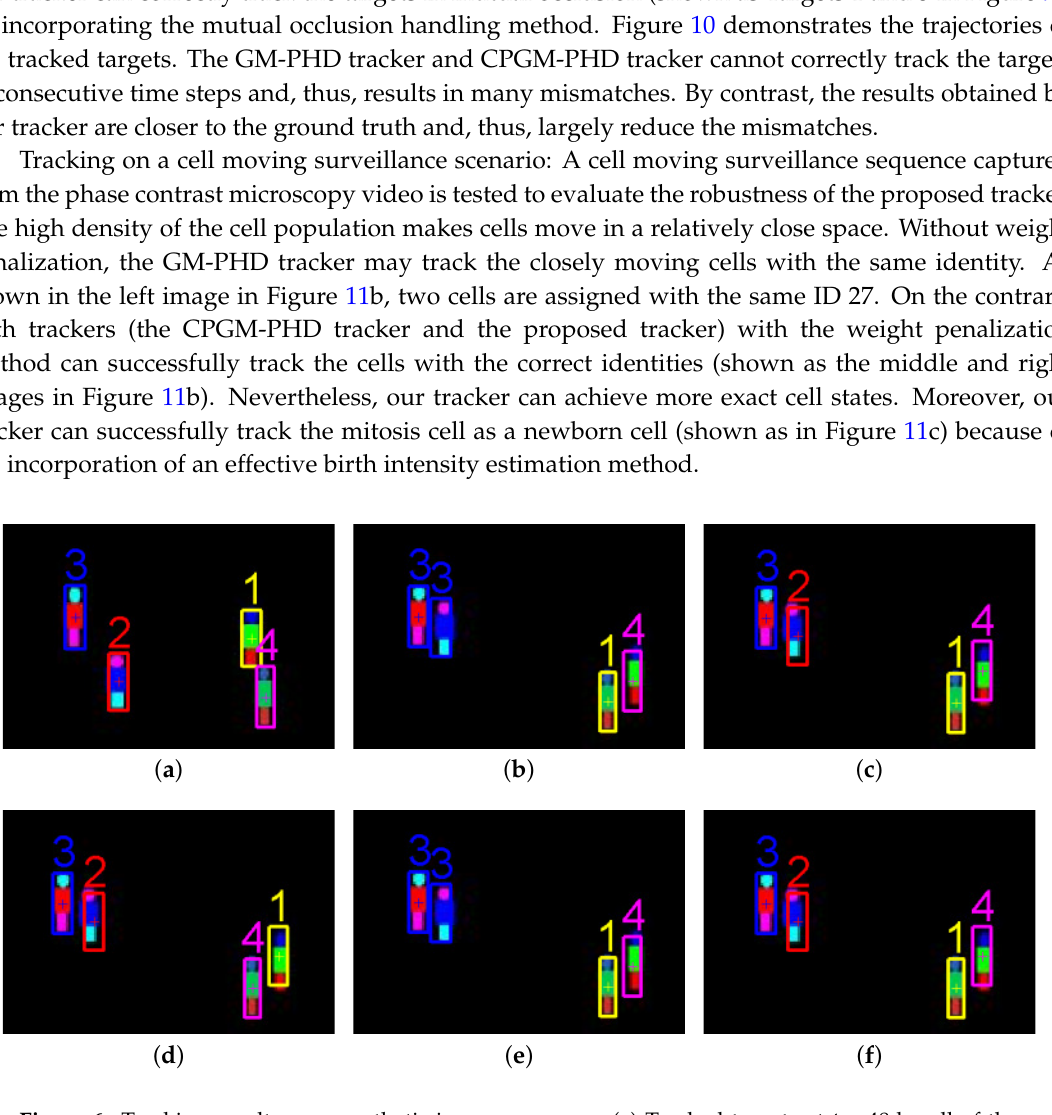
Figure 6. Tracking results on a synthetic image sequence. ( a ) Tracked targets at t = 48 by all of the trackers; ( b ) tracked targets at t = 49 by the GM-PHD tracker; ( c ) tracked targets at t = 49 by the collaborative penalized GM (CPGM)-PHD tracker; ( d ) tracked targets at t = 49 by our tracker with multi-feature fusion; ( e ) tracked targets at t = 49 by our tracker with the target area feature; ( f ) tracked targets at t = 49 by our tracker with the colour appearance